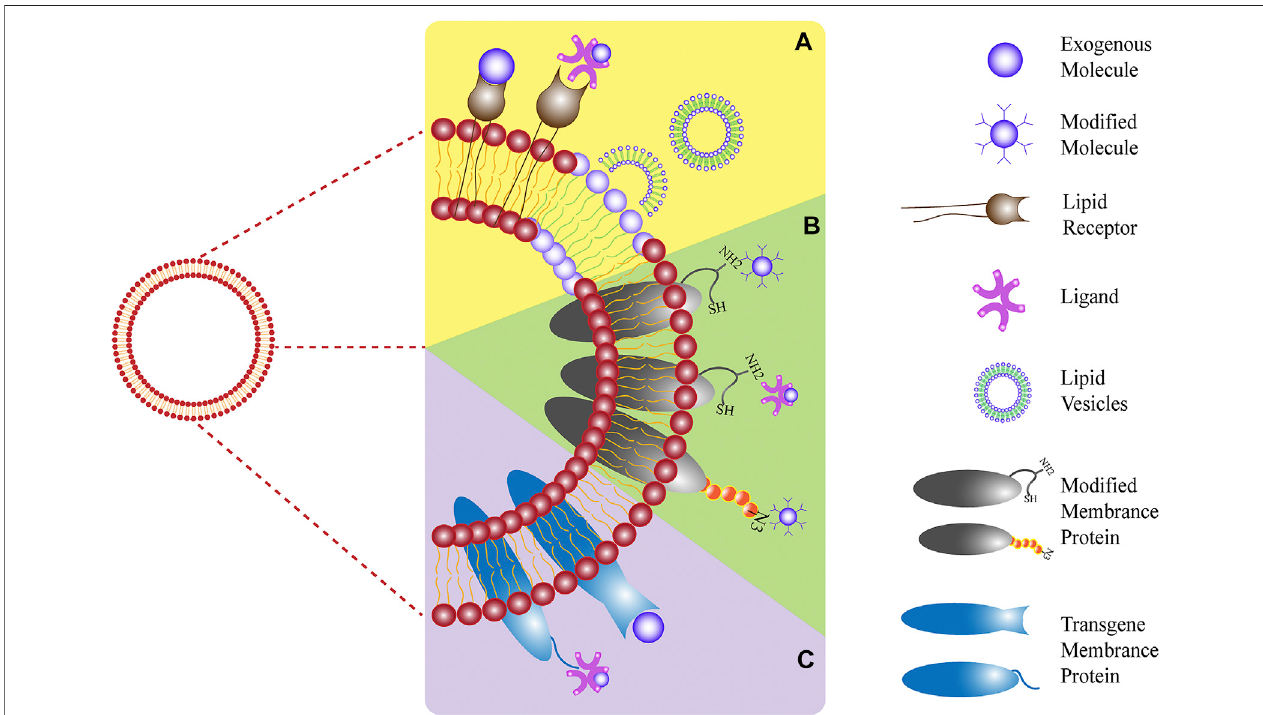
FIGURE 3 | Three modi fi cation strategies: (A) physical, (B) chemical, and (C) biological methods.